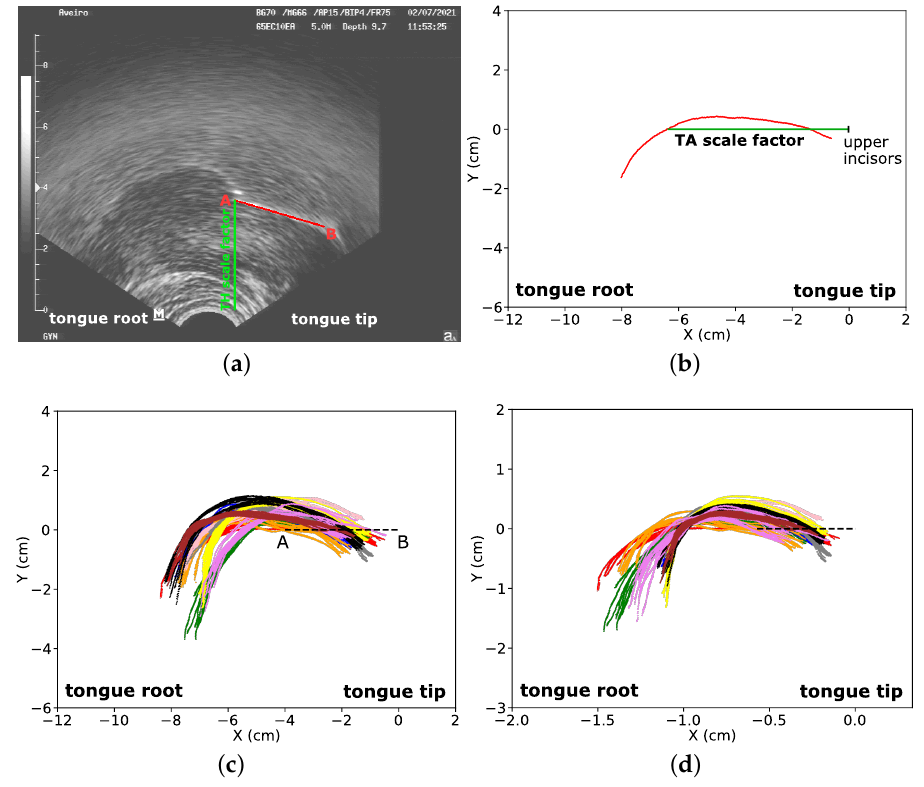
Figure 5. Top: Illustration of normalization measures for TH ( a ) and TA ( b ). Bottom: Sustained vowels [a] contours of all speakers rotated ( c ) and scaled ( d